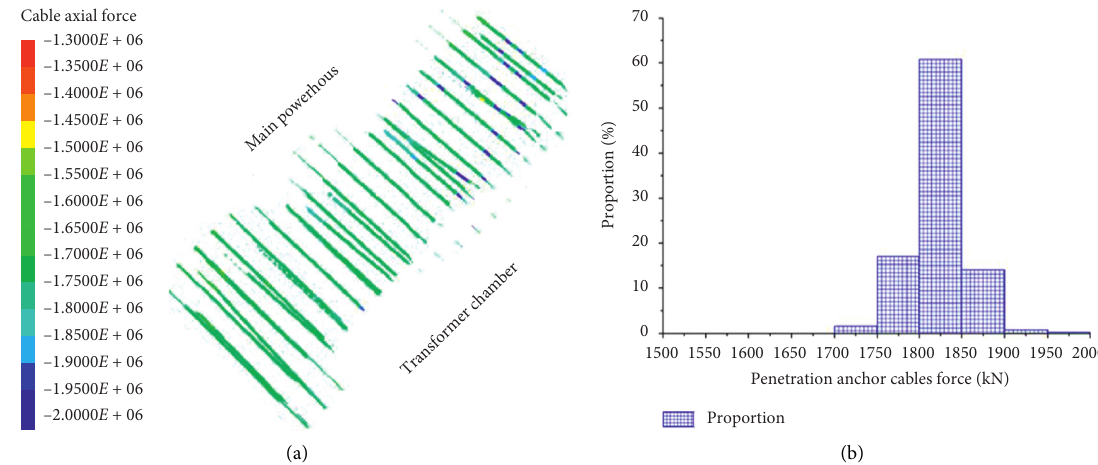
Figure 13: Cable axial force distribution of penetration anchor cables (negative sign indicates tension) (a). Axial force distribution of penetration anchor cables proportion (b).